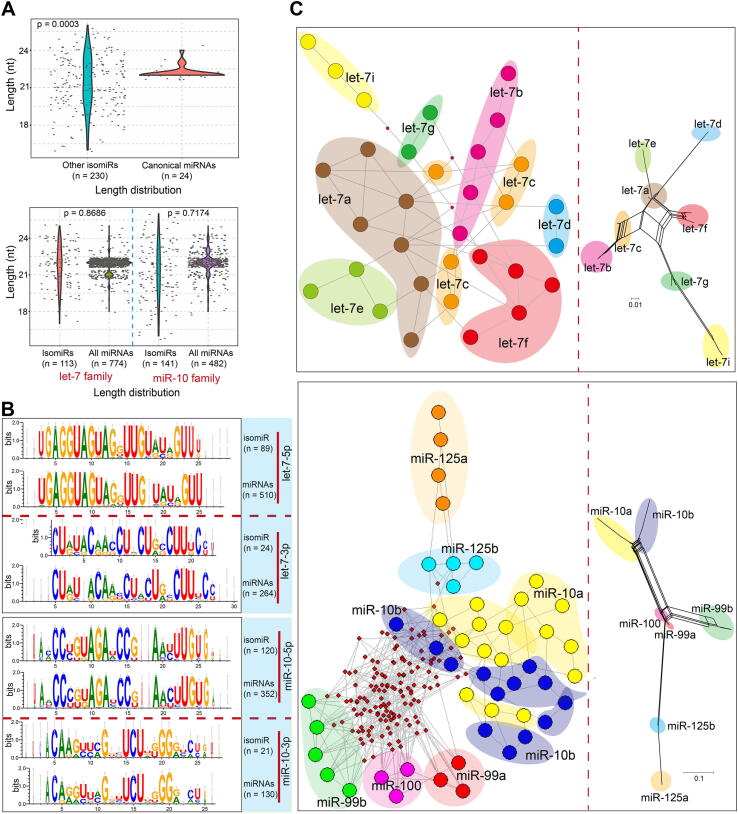
Correlations between internal isomiRs and external miRNAs, and phylogenetic relationships among isomiRs. (A) Length distributions of canonical miRNAs and their isomiRs from the two gene families, and length distributions of human isomiRs compared with mature miRNAs across animal species. (B) Sequence features of isomiRs and canonical miRNAs from the two gene families across animal species (5p and 3p were estimated). (C) Phylogenetic networks and trees of the most highly expressed isomiRs from 5p. IsomiRs with a RPM value ≥ 500 in any one sample were selected.